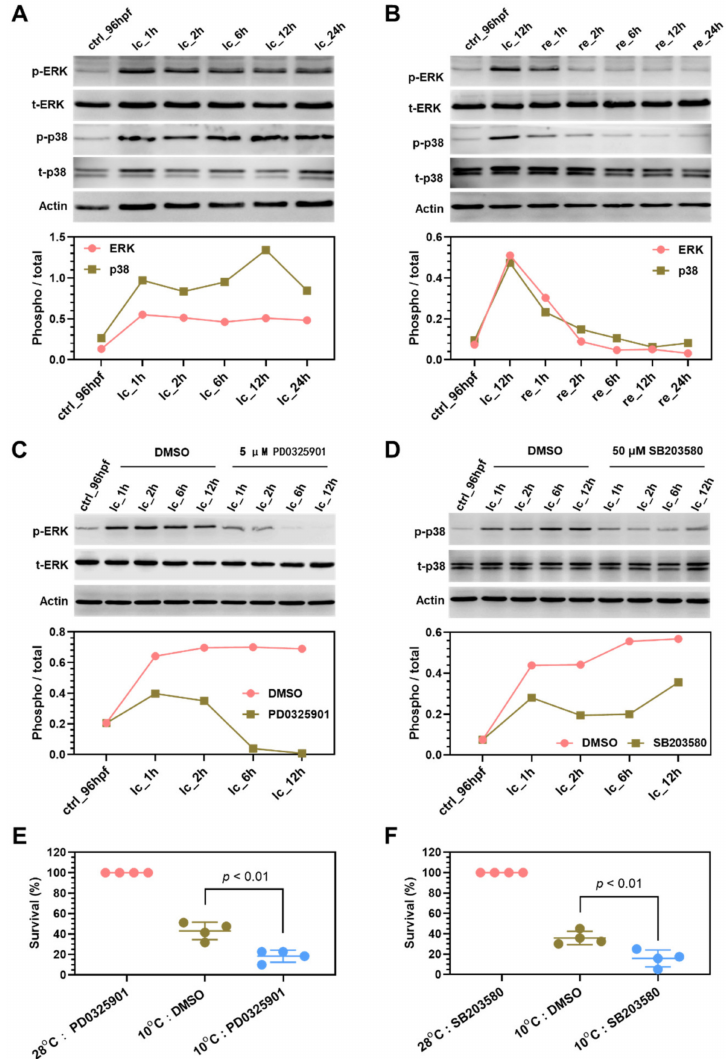
Figure 6. Functions of ERK and p38 MAPKs in regulating cold resistance of zebrafish larvae. ( A ) Ex- posure to cold stress induced phosphorylation of ERK and p38 MAPKs. ( B ) Phosphorylation level of ERK and p38 MAPKs decreased during recovery at 28 ◦ C. ( C ) PD0325901 treatment completely inhibited phosphorylation of ERK. ( D ) SB203580 treatment partially decreased phosphorylation of p38 MAPKs. The line charts below the Western blots indicate ratio of the phosphorylated ERK and p38 to the total protein. ( E , F ) Inhibiting the activity of ERK ( E ) and p38 ( F ) sensitized zebrafish larvae to cold stress. PD0325901 (5 µ M) and SB203580 (50 µ M) were added to the medium upon lethal cold exposure to inhibit the activity of ERK and p38,